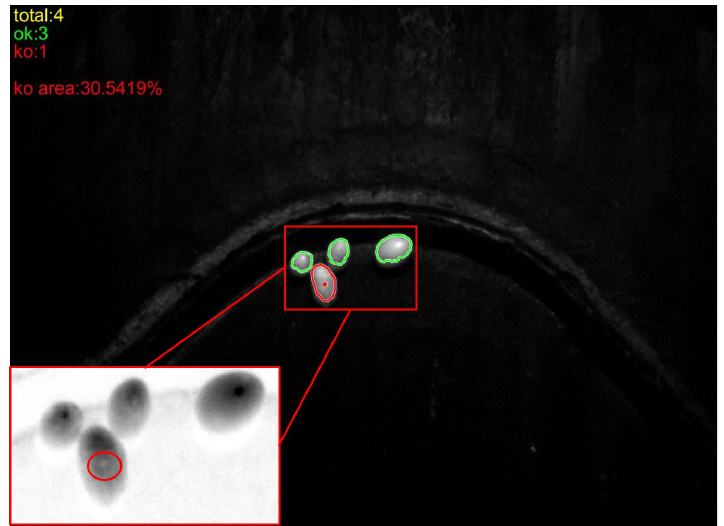
Figure 5. Example of the detection of defects in